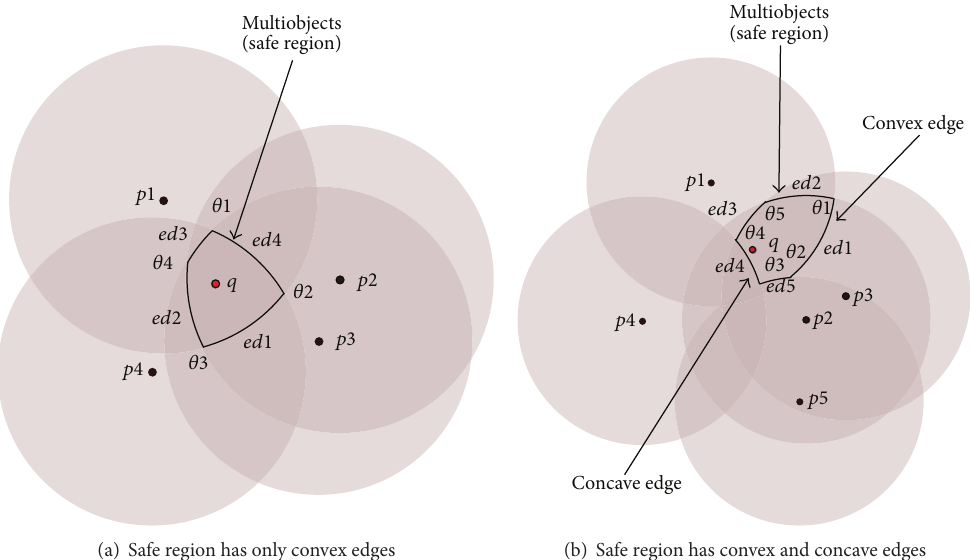
Figure 7: Safe regions with different